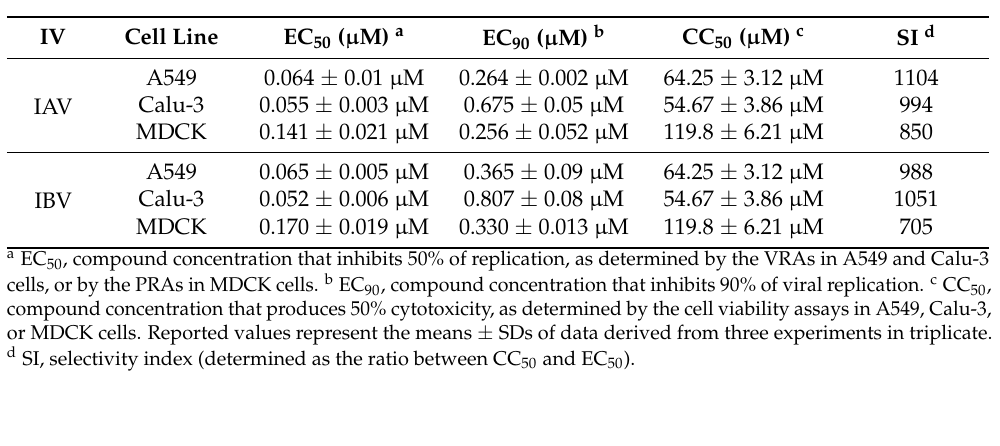
Figure 2. Inhibition of IAV and IBV replication by MEDS433. ( A ) Chemical structure of MEDS433, the h DHODH inhibitor investigated as an anti-IV agent in this study. ( B , C ) VRAs were performed in A549 cells infected with IAV ( B ) or IBV ( C ) and treated with increasing concentrations of MEDS433 or brequinar 1 h before, during, and post-infection. At 48 h p.i., the cell supernatants were harvested and titrated by the plaque assay in MDCK cells. ( D , E ) PRAs were performed in MDCK cell monolayers infected with IAV ( D ) or IBV ( E ) and, where indicated, treated with increasing concentrations of MEDS433 or brequinar. At 48 h p.i., the viral plaques were microscopically counted and converted in viral titer (PFU/mL). The concentrations of MEDS433 or brequinar producing 50% and 90% reductions in plaque formation (EC 50 and EC 90 ) were then calculated. Data shown are the means ± SDs (error bars) of three independent experiments performed in triplicate and analyzed by a two-way ANOVA, followed by Dunnett’s multiple comparison test. Statistical analysis was performed by comparing MEDS433-treated samples with the brequinar-treated samples for each condition. * ( p < 0.01); ** ( p < 0.001); *** ( p < 0.0001). Table 1. Antiviral activity of MEDS433 against representative influenza